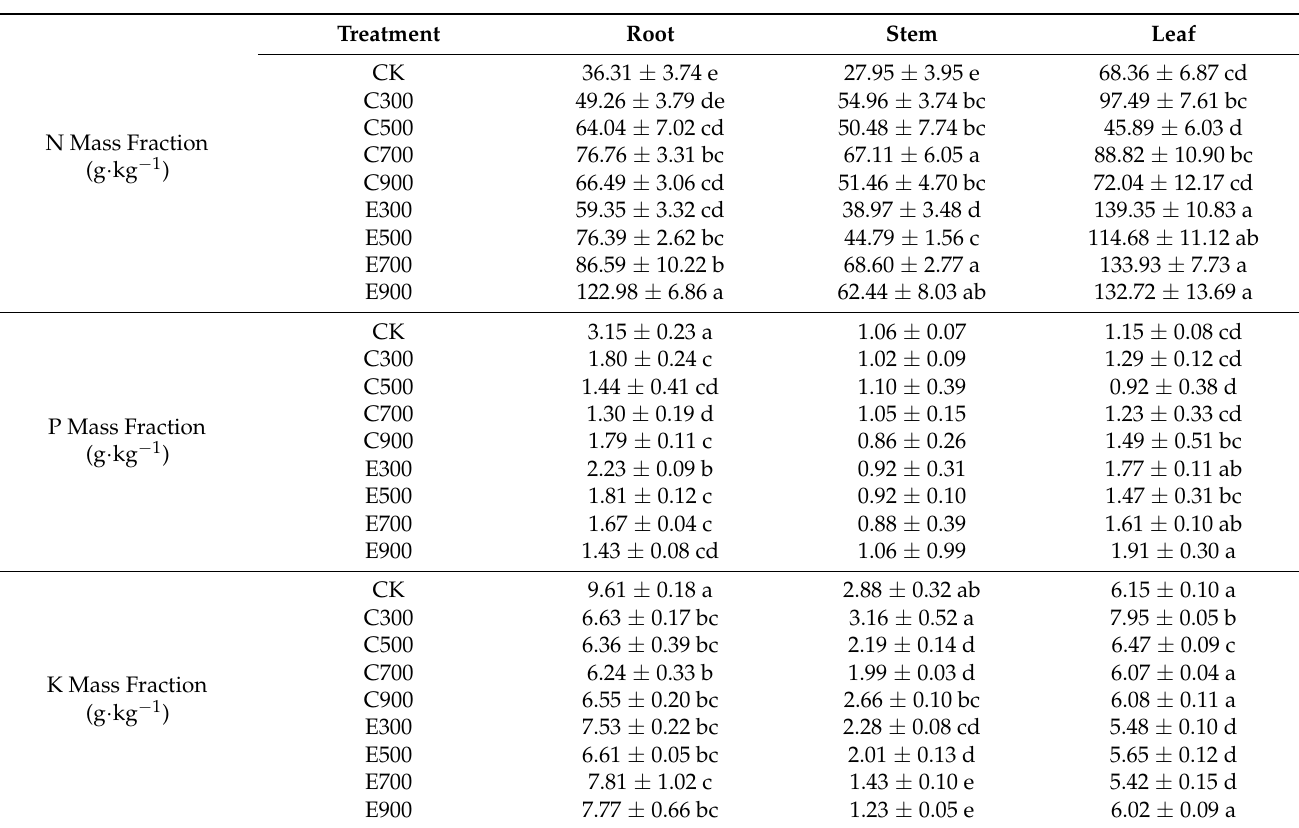
Table 2. Effects of fertilization on K, P, and K mass fraction of roots, stems, and leaves of Q. nuttallii container